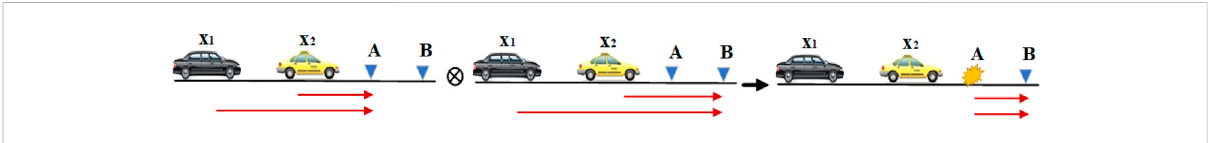
FIGURE 5 Ray diagram sketch of surface waves reconstruction by seismic interferometry.